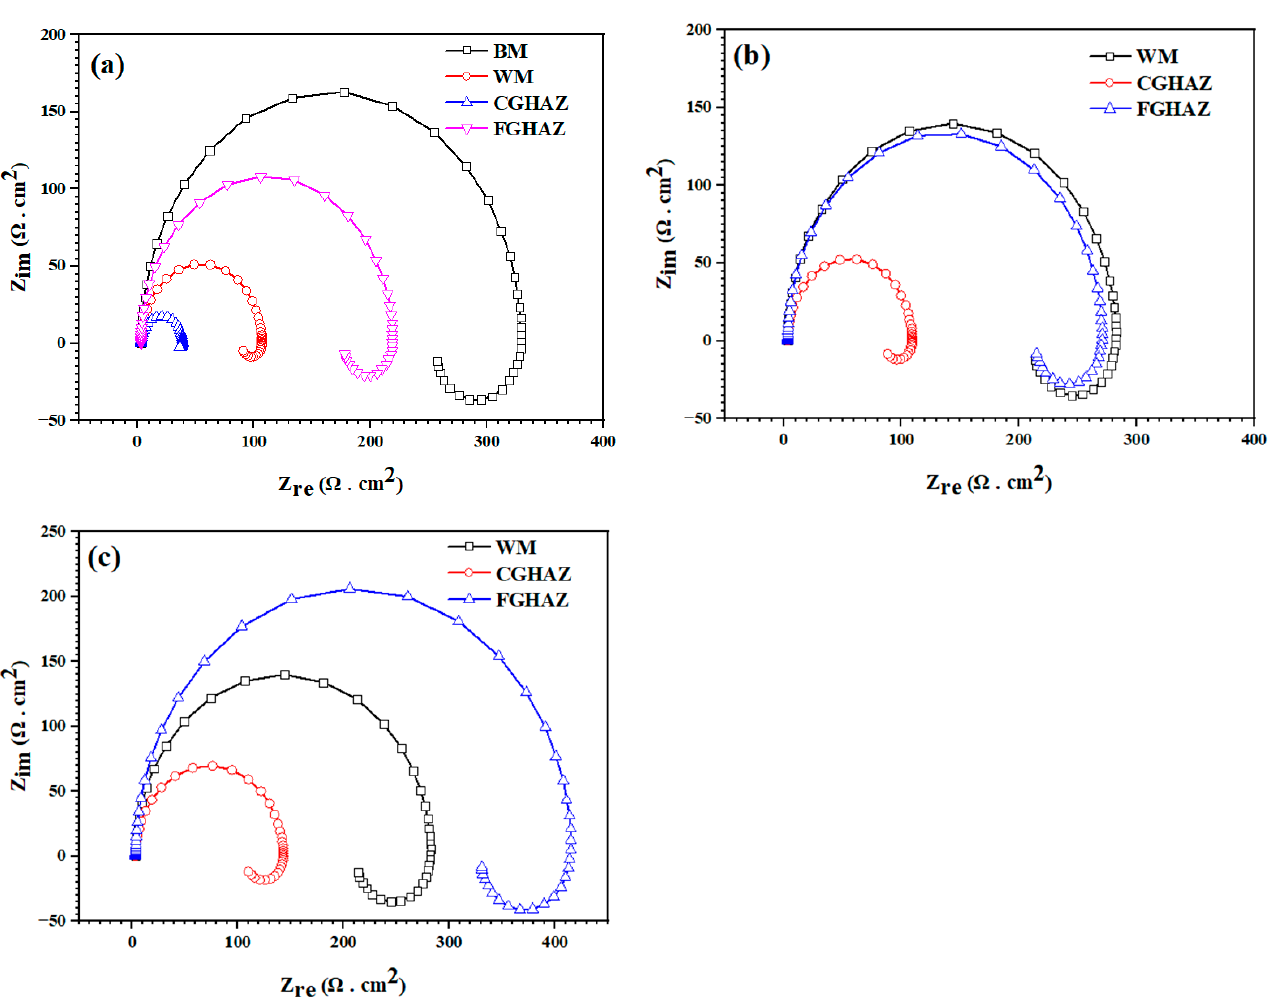
Figure 12. EIS results for 0 h immersion of BM and different zones in laser welded joints in NACEA solution with saturated H 2 S at 50 °C : ( a ) 2.86; ( b ) 4 and ( c ) 6.67 kJ/cm. Table 4. The fitted values of EIS for different samples under immersion for 0 h.